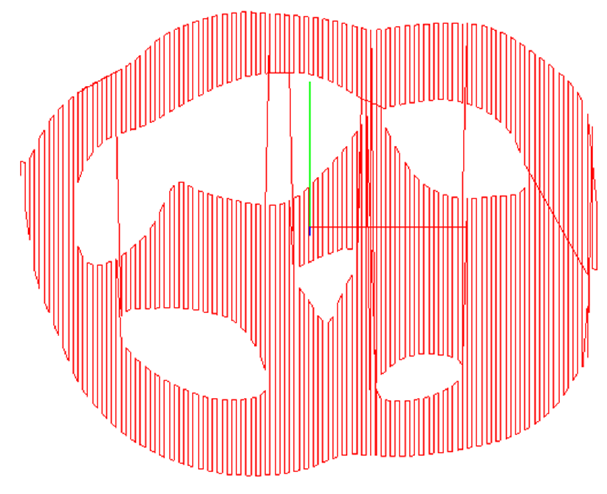
Figure 3. Design of the path for laser scanning for single-layered preparation.